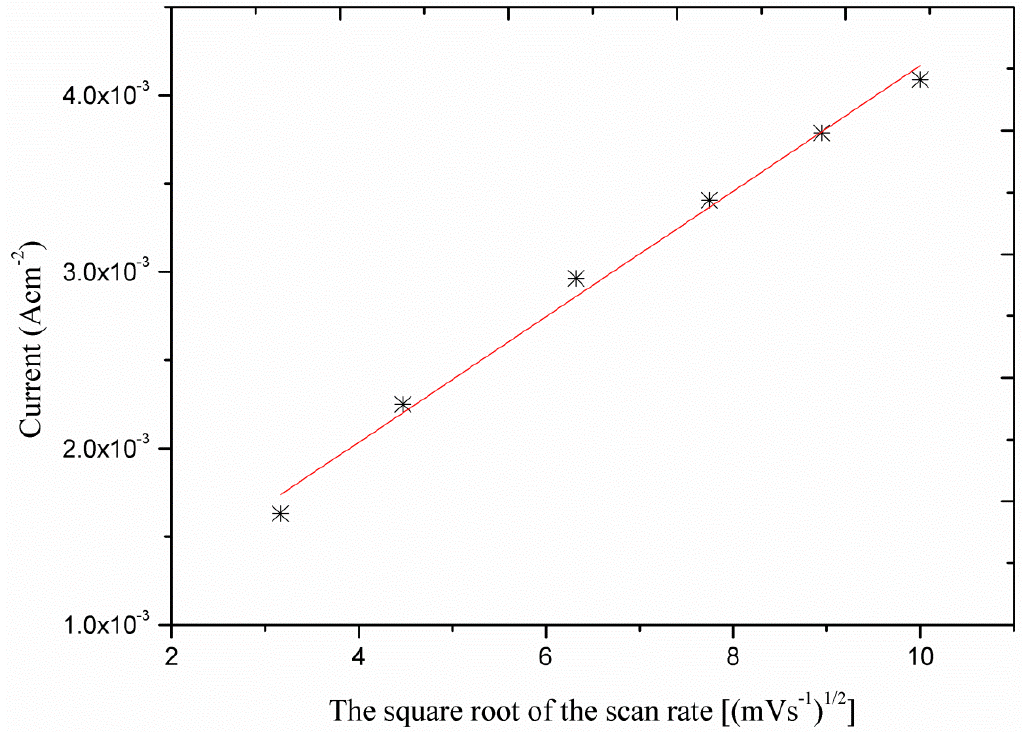
Figure 4. Calibration curve of the current versus different scan rate measured in 1.96 mM glucose